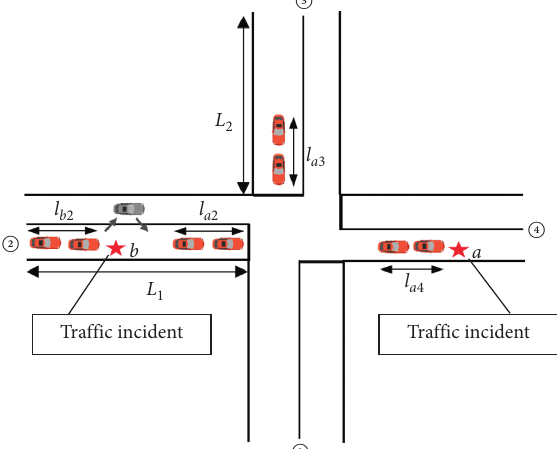
Figure 1: An intersection layout influenced by traffic